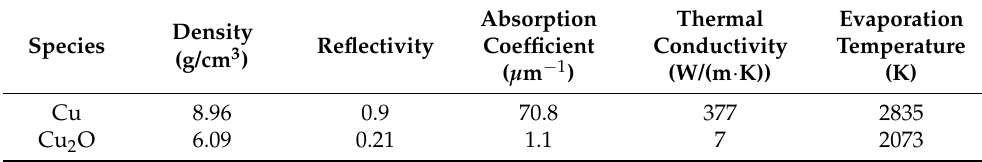
Table 1. Physical properties of Cu and Cu 2